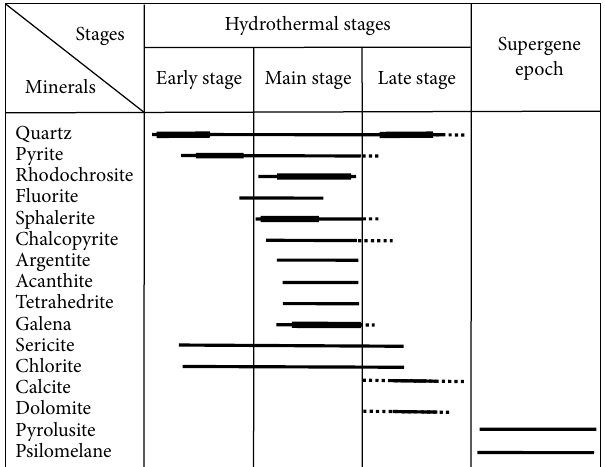
Figure 5: Paragenetic sequence of minerals in the Zhijiadi deposit.